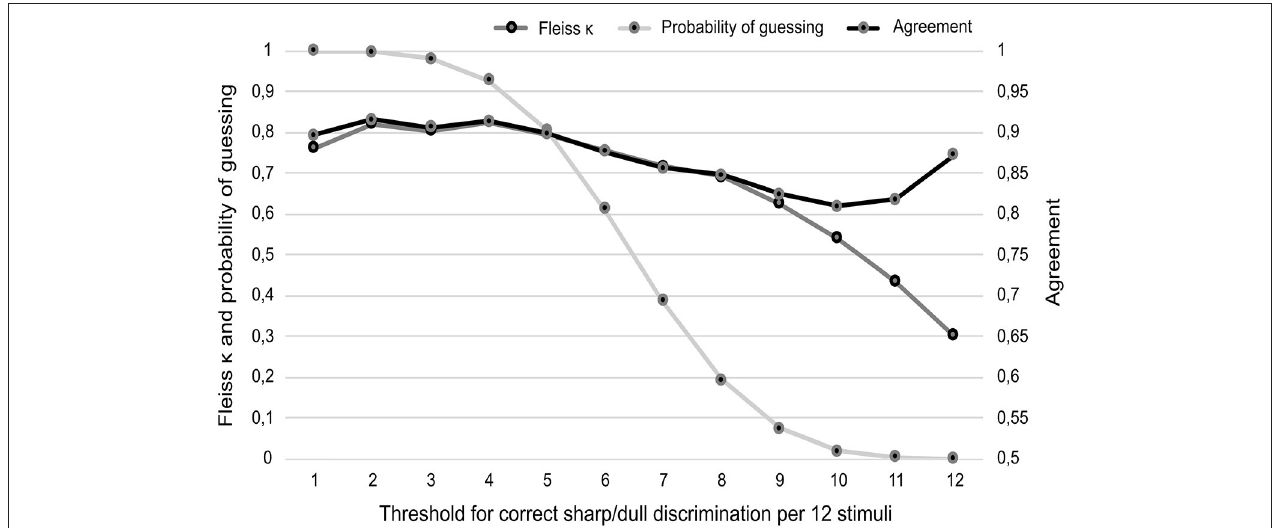
FIGURE 1 | Results of percentage agreement and interrater reliability for three raters in due consideration of the probability of guessing the correct result (vertical axes). The different thresholds in terms of classification of an intact sharp/dull discrimination are given on the (horizontal axis). Data collection was based on aliquot random repetition of in total 12 sharp and dull stimuli. For the sake of interpretability, the scaling of the vertical axes is arranged in a ratio of 1:2 for Fleiss κ / probability of guessing and percentage agreement. Agreement is presented as decimal fraction of the